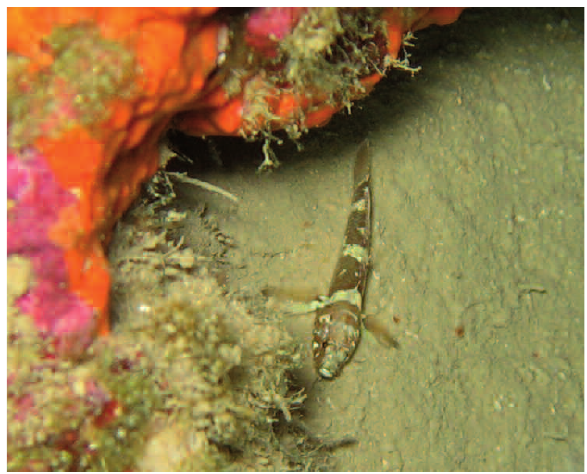
Fig. 1. Underwater photograph of Didogobius splechtnai in a cave (depth of 20–30 m), near Antibes, France (lat 43°33’N, long 7°09’E);